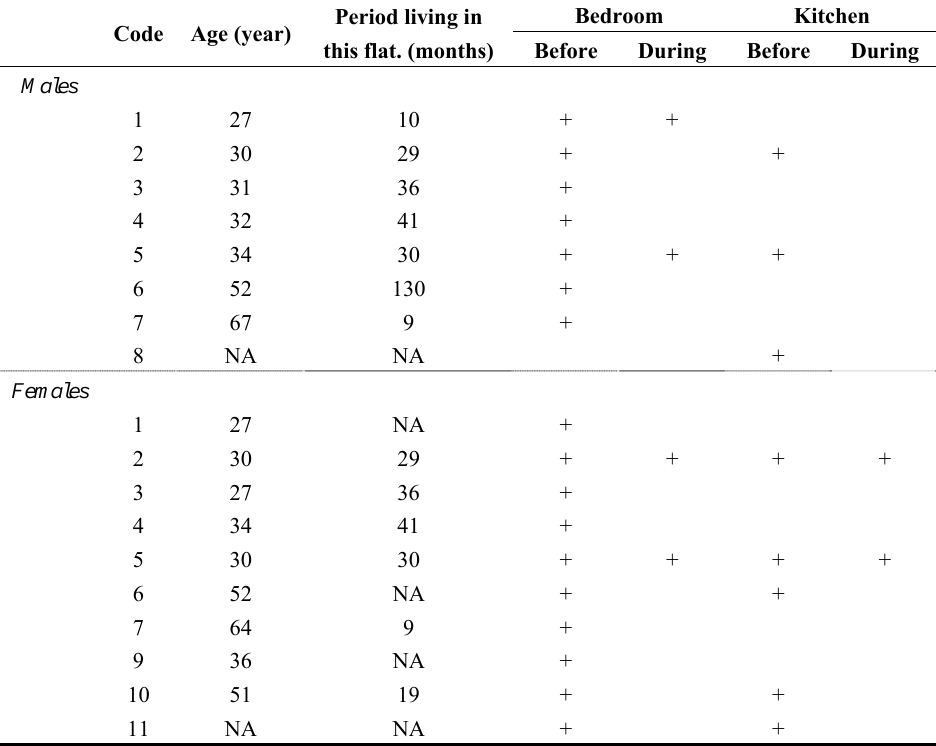
Table 4. A list of residents reported that they experienced some symptom because they moved into flats: before and during the sampling period.